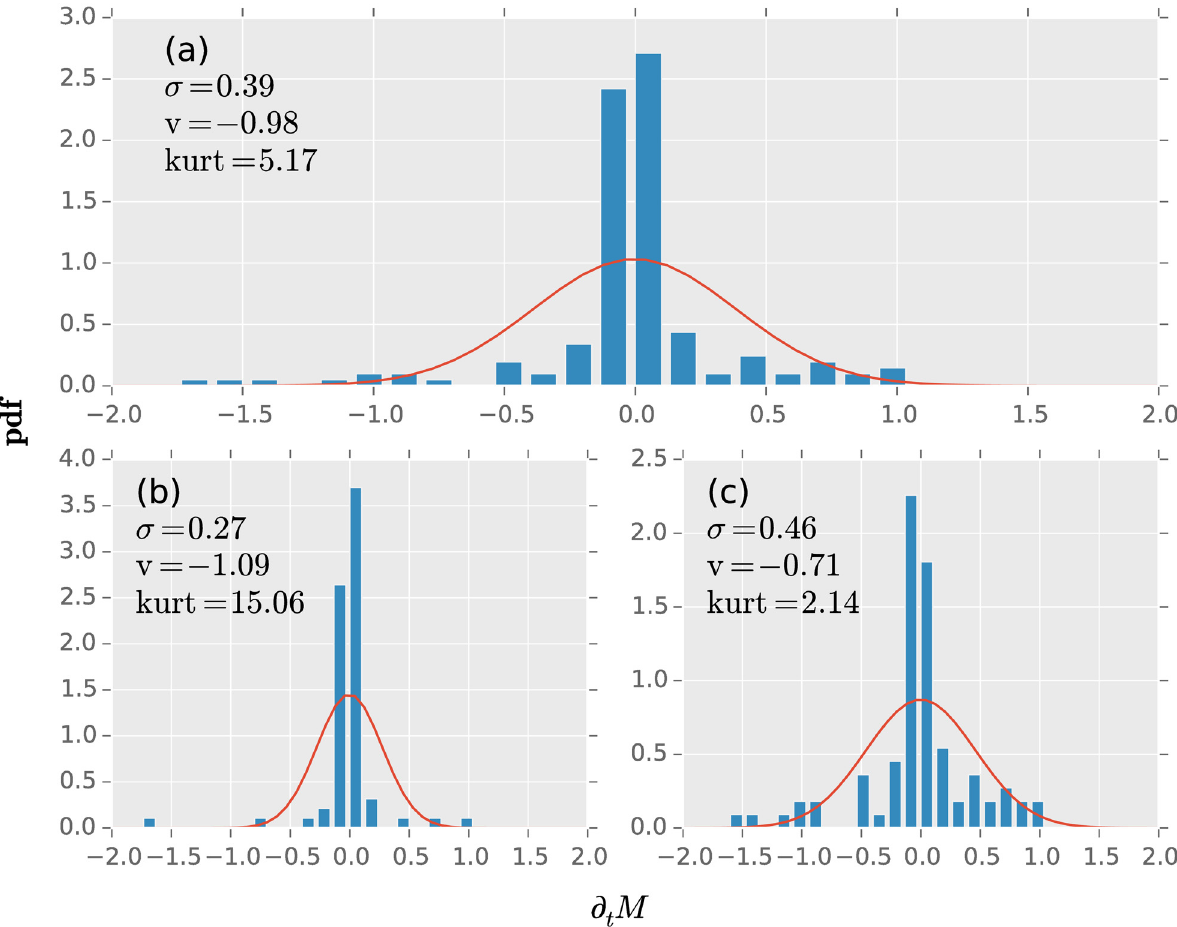
Fig 4. The average investing strategy time derivation probability functions (pdf) of (a) the whole observation time from 2003 until 2016; (b) from 2003 until 2009; and (c) from 2009 until 2016. Between 2003 and 2009 the pdf densely centered around h @ t M i = M i = − 0.00 ± 0.05 is also centered. The − 0.00 ± 0.04 exhibiting a kurt = 15.06 ± 1.07 and an extreme event at − 1.5. Afterwards the h @ t kurtosis dropped to kurt = 2.14 ± 1.07 and shows a standard deviation of σ = 0.46 ± 0.05 in comparison to σ = 0.27 ± 0.08. The skewness changed from v = − 1.09 ± 2.44 before 2009 and v = − 0.71 ± 0.36. The whole observation time pdf has h @ t M i = − 0.00 ± 0.03 with σ = 0.39 ± 0.04, kurt = 5.17 ± 1.60 and v = − 0.98 ± 0.50. Note, that these values were estimated with 1000 bootstrapping samples. The comparison plot is a normal distribution with zero mean and the corresponding standard deviations for each time